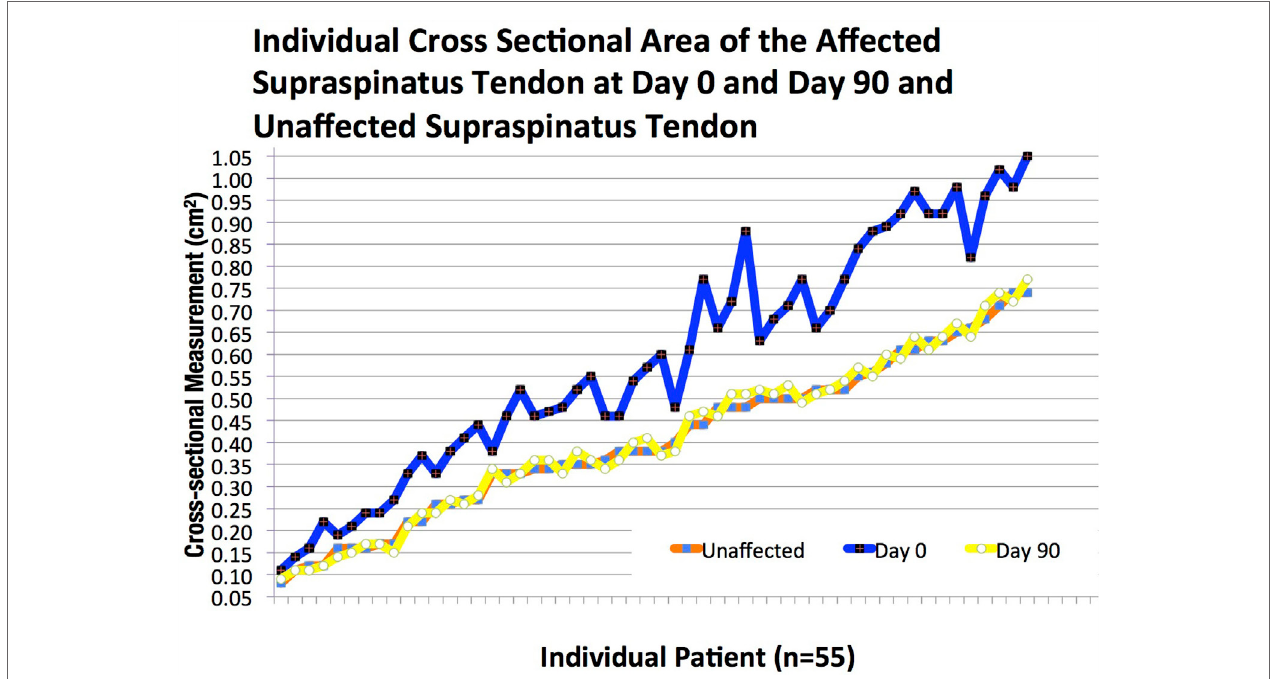
FigUre 7 | There was a significant difference in cross-sectional area (csa) noted between the injured and contralateral normal supraspinatus tendon prior to aDPc-PrP therapy at day 0 ( p = 0.002)